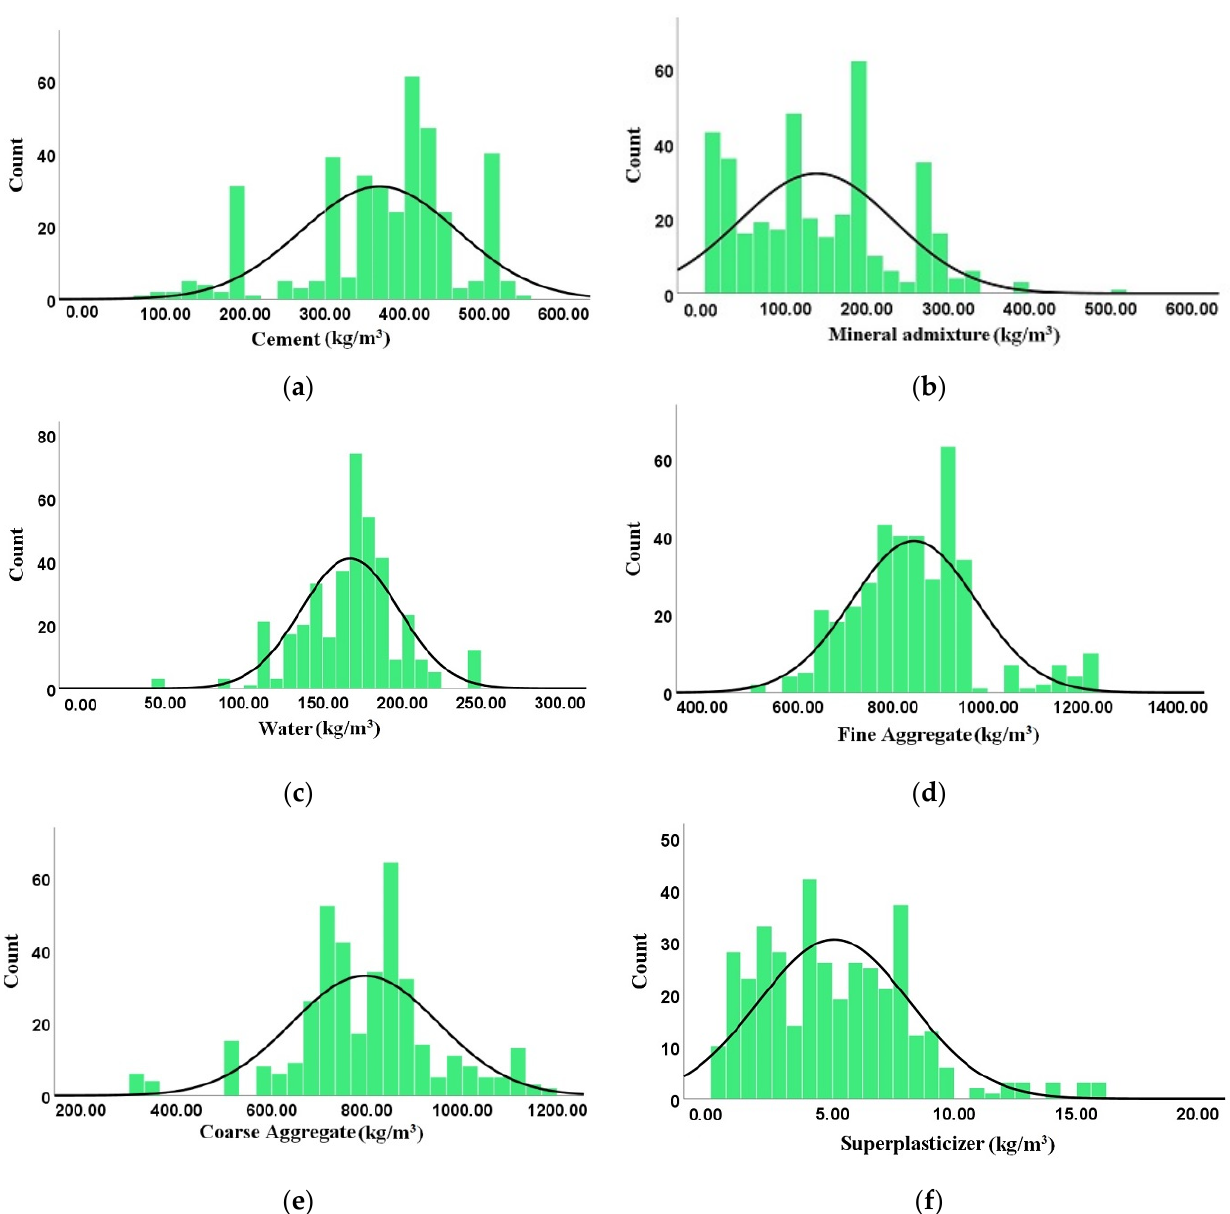
Figure 5. Frequency distribution normal curve of input variables: ( a ) Cement; ( b ) Mineral admixture; ( c ) Water; ( d ) Fine Aggregate; ( e ) Coarse Aggregate; ( f ) Superplasticizer.